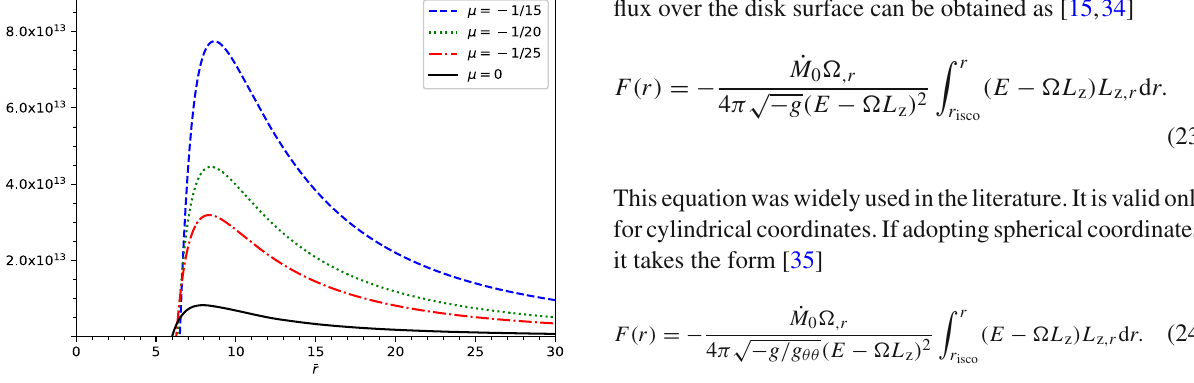
Fig. 1 The energy flux F ( ¯ r ) from a disk around a BH in EACT for different negative values of μ